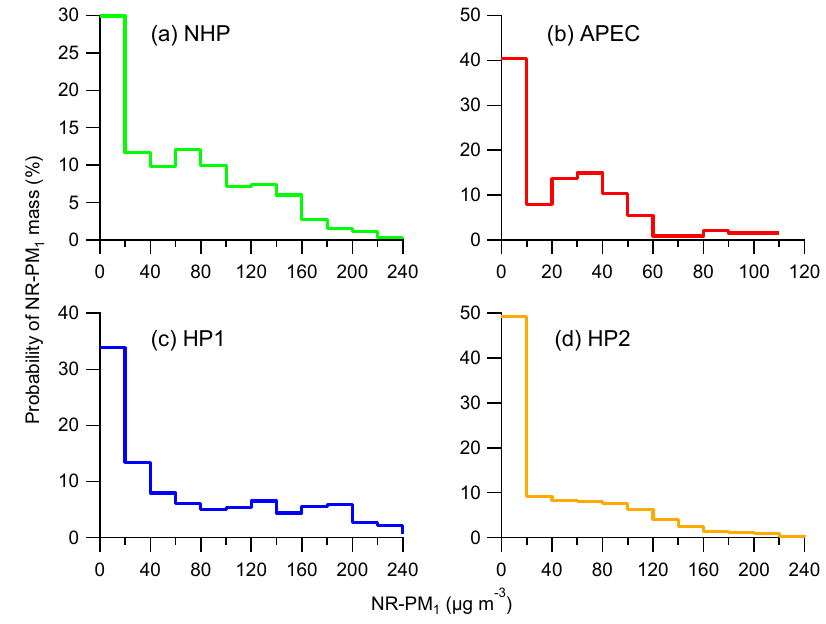
Figure 2. Probability of NR-PM 1 mass during four different periods (a–d) , i.e., NHP, APEC, HP1, and HP2.